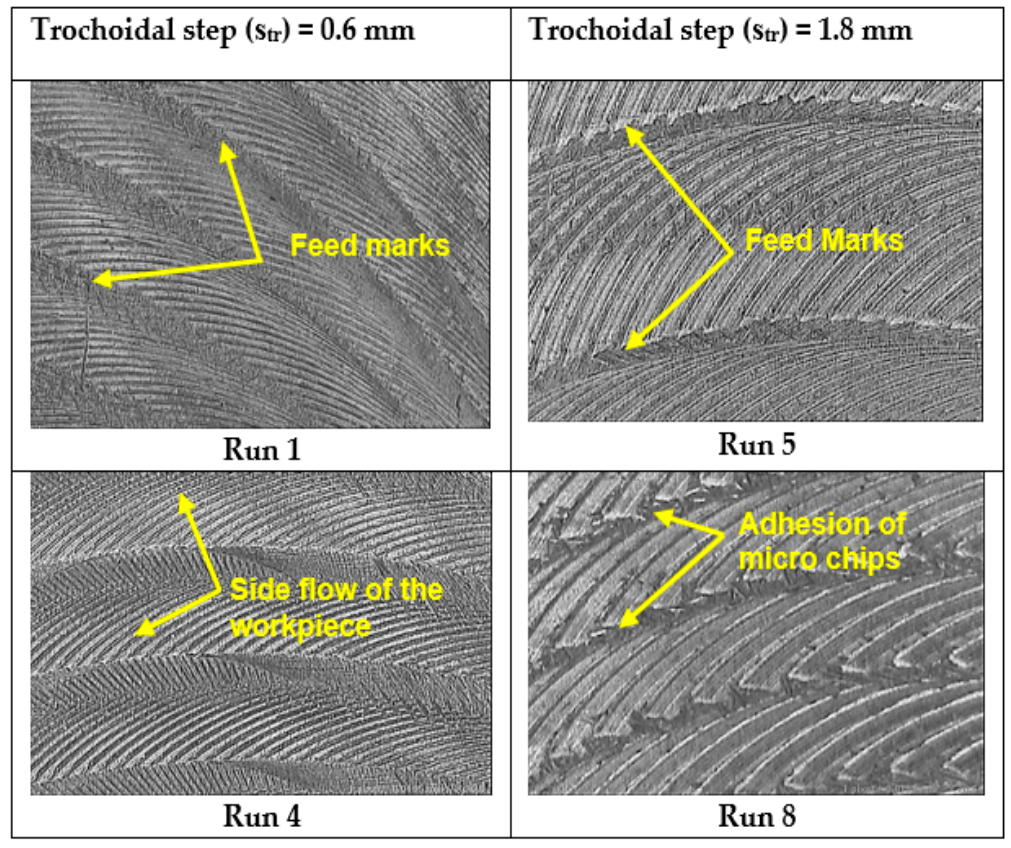
Figure 9. E ff ect of trochoidal step on surface roughness using Vision measuring system (corresponding Figure 9. Effect of trochoidal step on surface roughness using Vision measuring system Materials 2019 , 12 , x FOR PEER REVIEW to run numbers in Table 4). (corresponding to run numbers in Table 4).